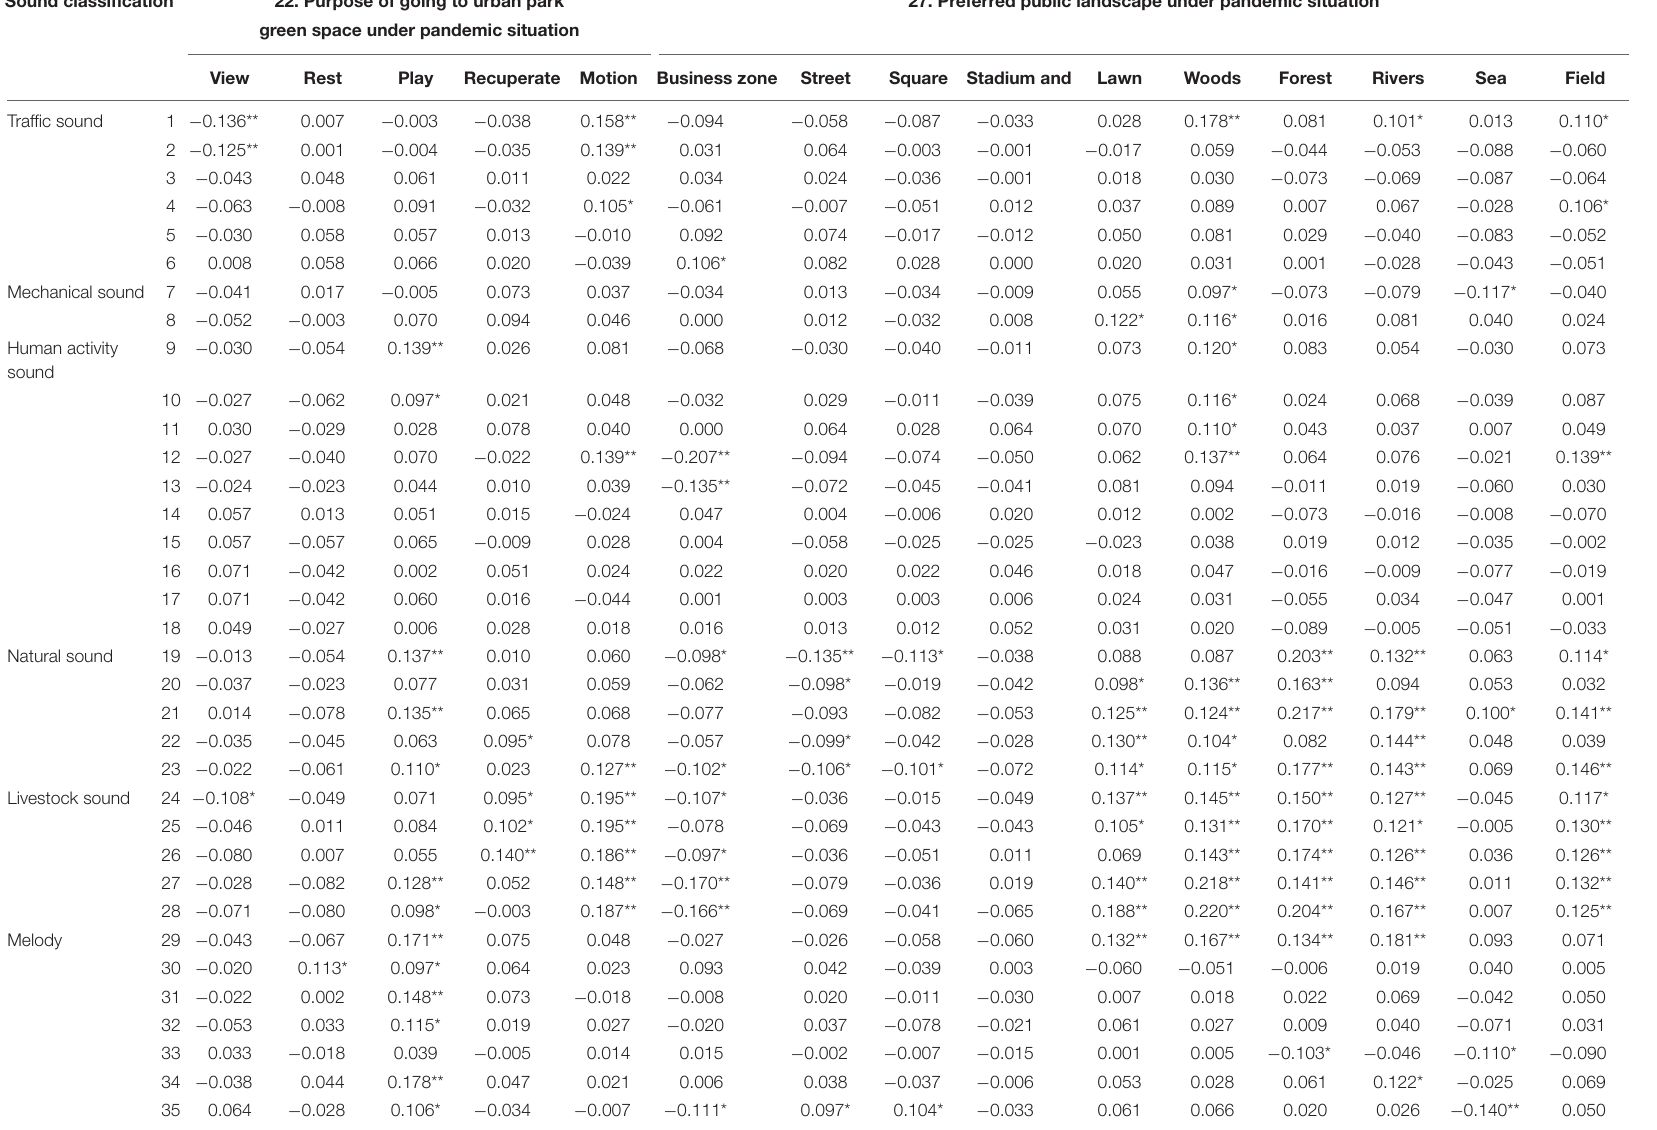
TABLE 3 | Correlation between public landscape space preference and soundscape preference 2 (code is shown in Table 1